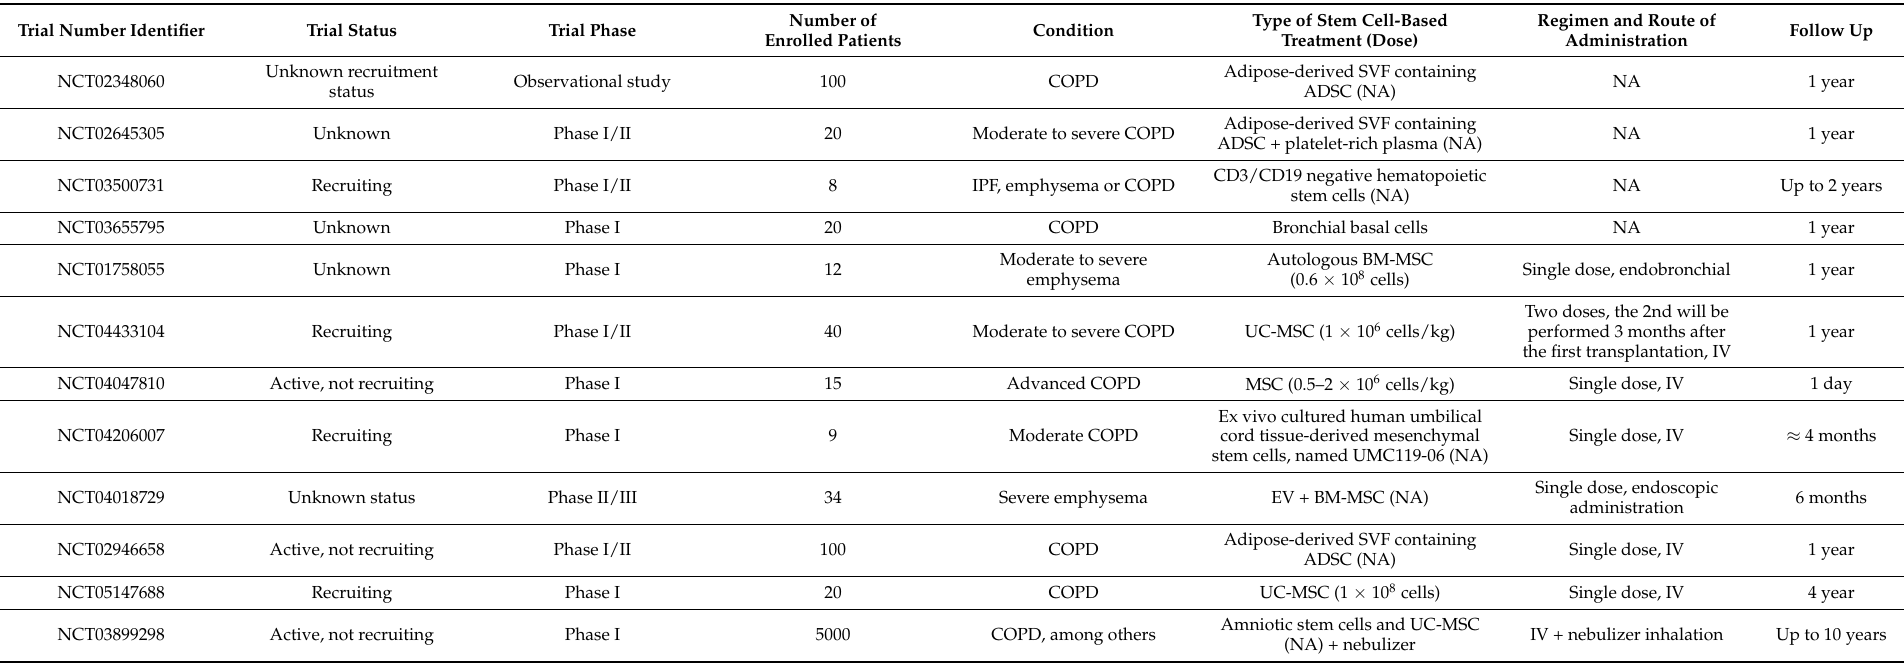
Table 2. Ongoing clinical trials on stem cell-based regenerative therapies for COPD currently registered at ClinicalTrials.gov, accessed on 24 May